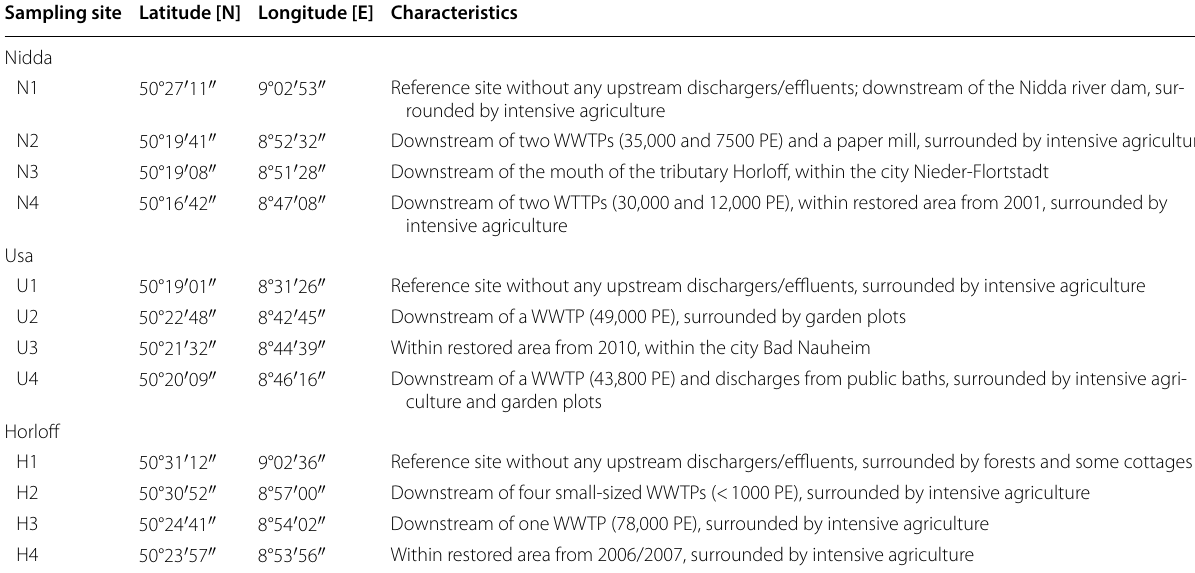
Table 2 Overview of the reference and sampling sites at the rivers Nidda, Usa, and Horloff Sampling site Latitude [N] Longitude [E]